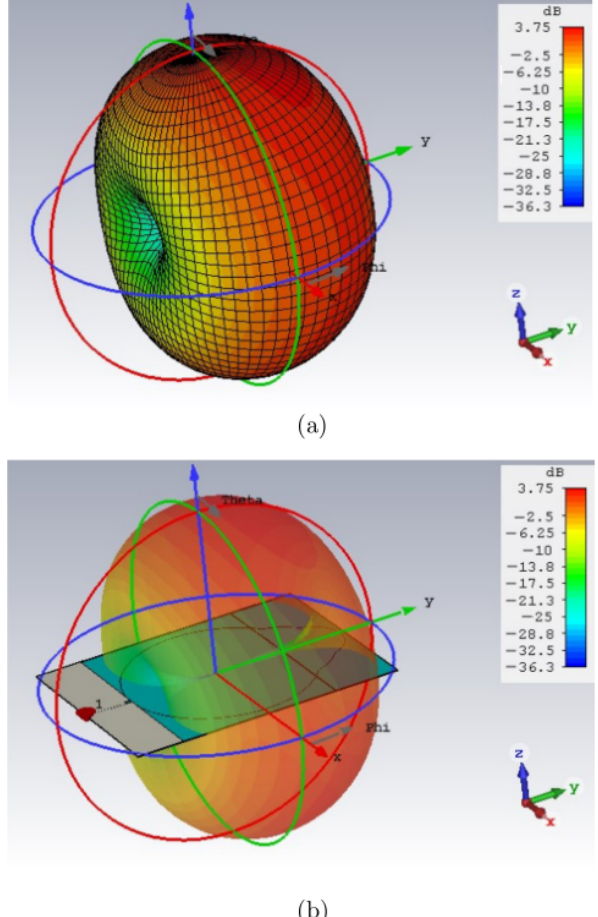
Figure A6. Simulated 3D radiation pattern of the antenna obtained at 450 MHz: ( a ) standard diagram and ( b ) radiation pattern and the patch antenna.